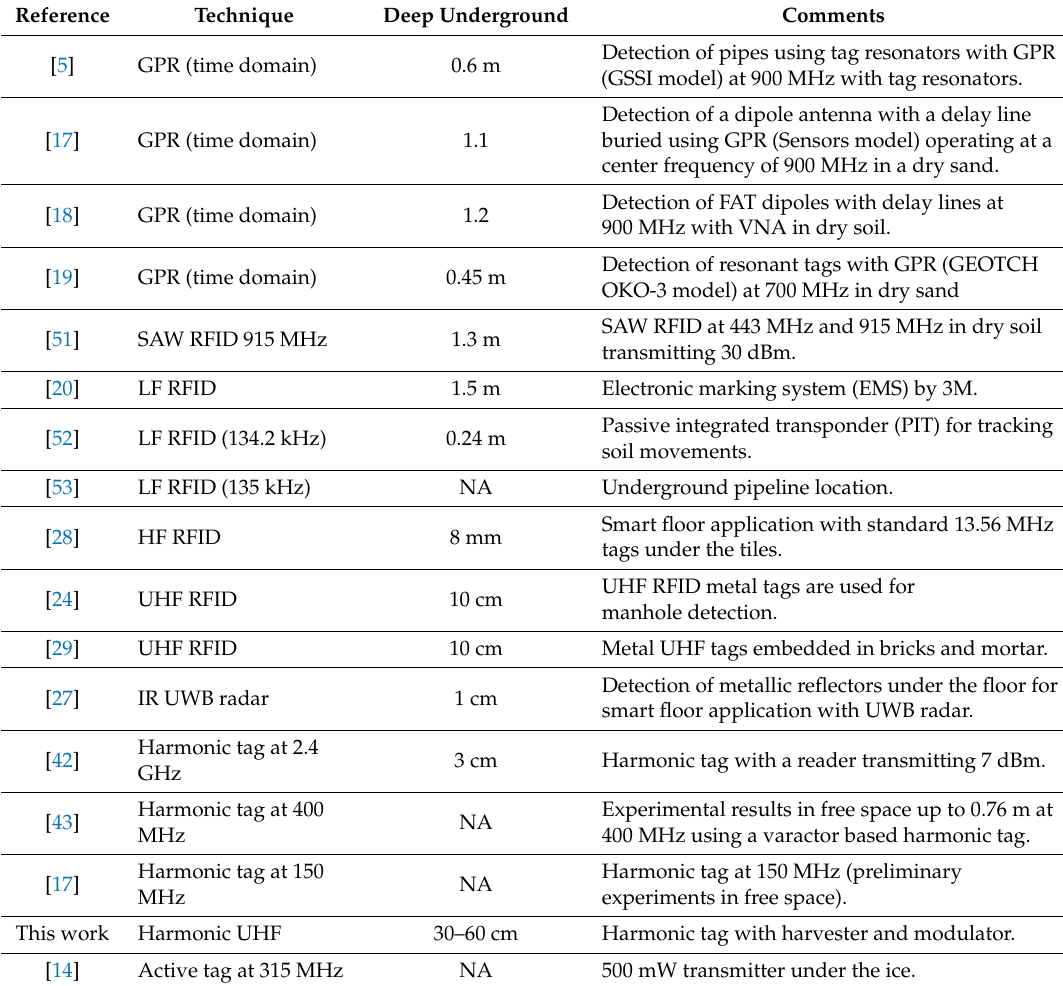
Table 3. Comparison of different techniques for detecting underground objects. GPR—ground penetrating